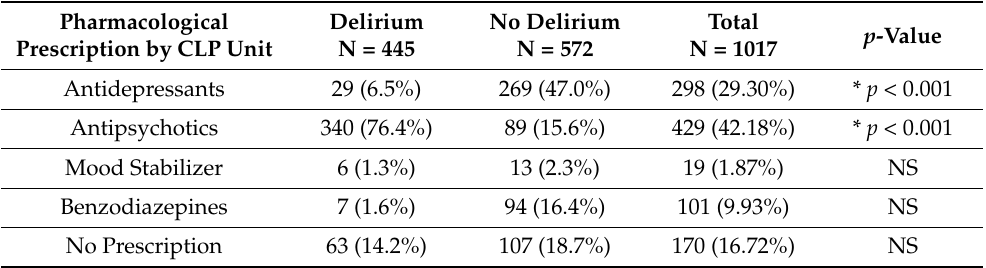
Table 3. Treatment of patients with delirium and patients with another psychiatric diagnosis (non- delirium) by CLP